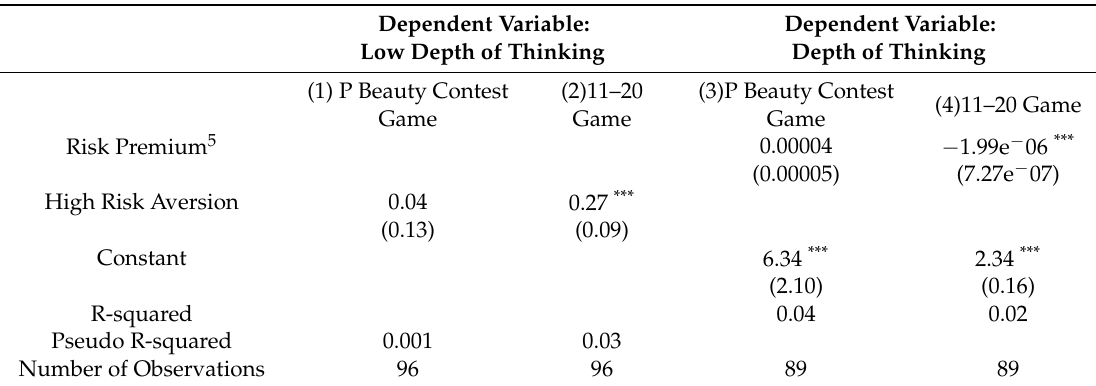
Table 2. The Determinants of Depth of